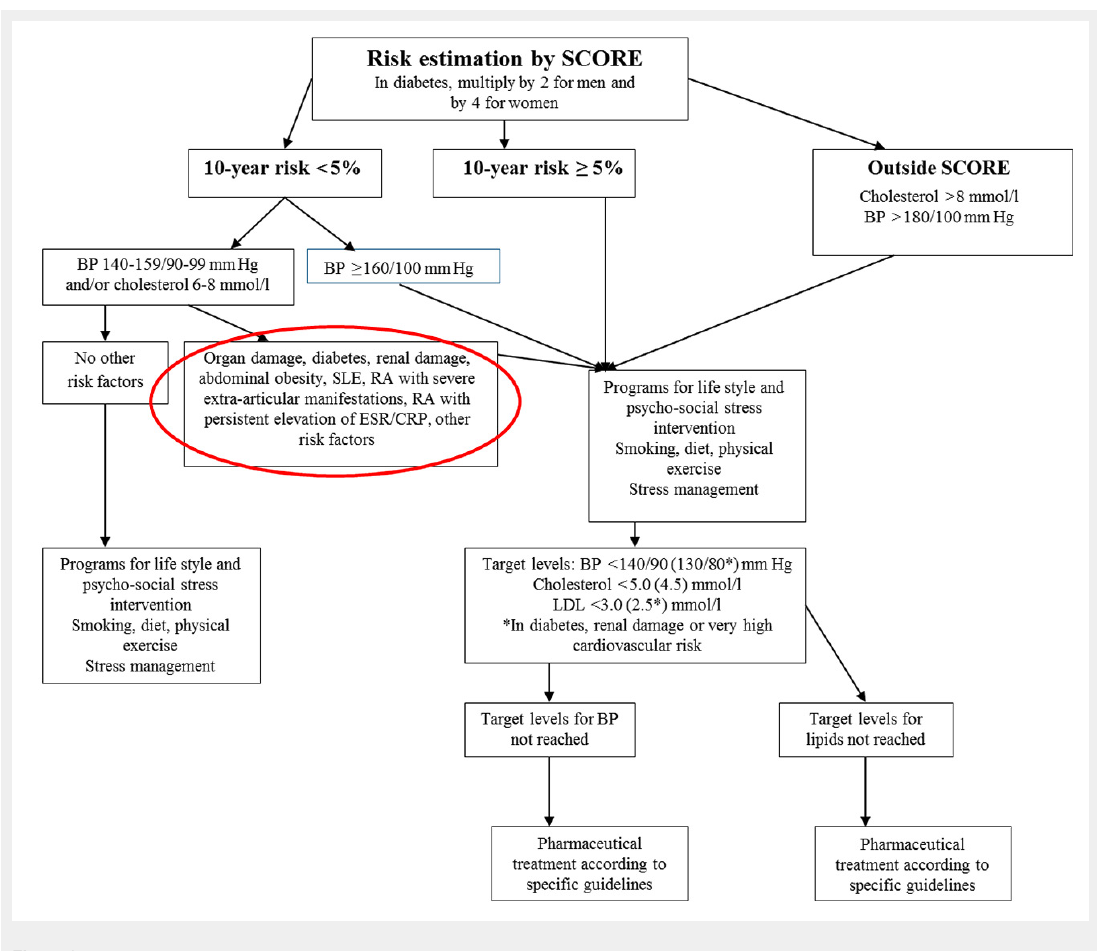
Figure 2 Recommended decision algorithm for interventions in the primary prevention of cardiovascular disease (CVD) in patients with rheumatoid arthritis and other inflammatory rheumatic disorders. This is based on estimation on the 10-year risk of death from CVD, using the SCORE system [77]. Reproduced, with permission, from: The Swedish Society of Rheumatology. Guidelines for cardiovascular primary prevention in patients with inflammatory rheumatic disease [75]. BP = blood pressure; CRP = C-reactive protein; ESR = erythrocyte sedimentation rate; LDL = low density lipoprotein; RA = rheumatoid arthritis; SCORE = Systematic COronary Risk Evaluation; SLE = systemic lupus